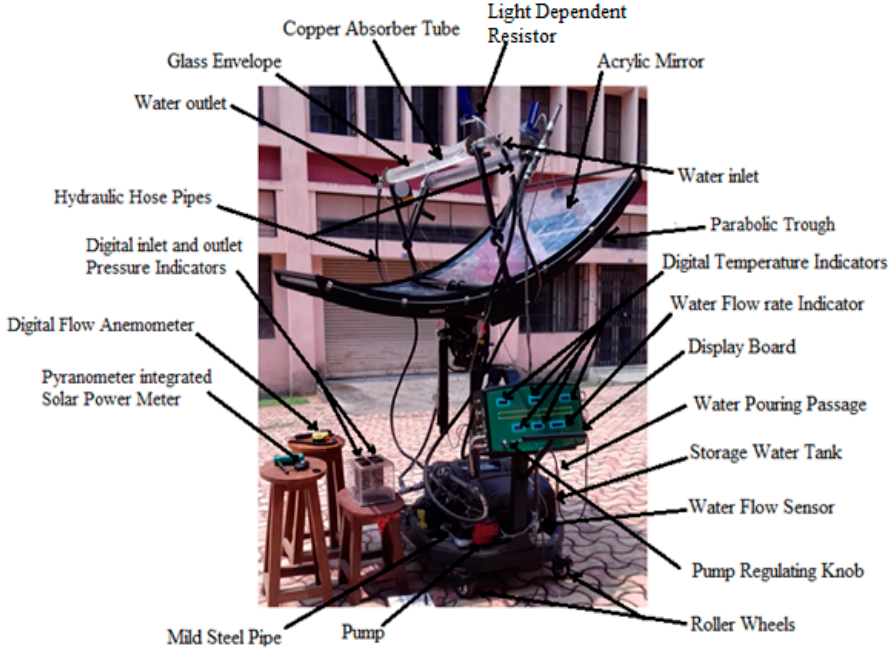
Figure 3. Photographic view of the CPCSWH experimental setup.